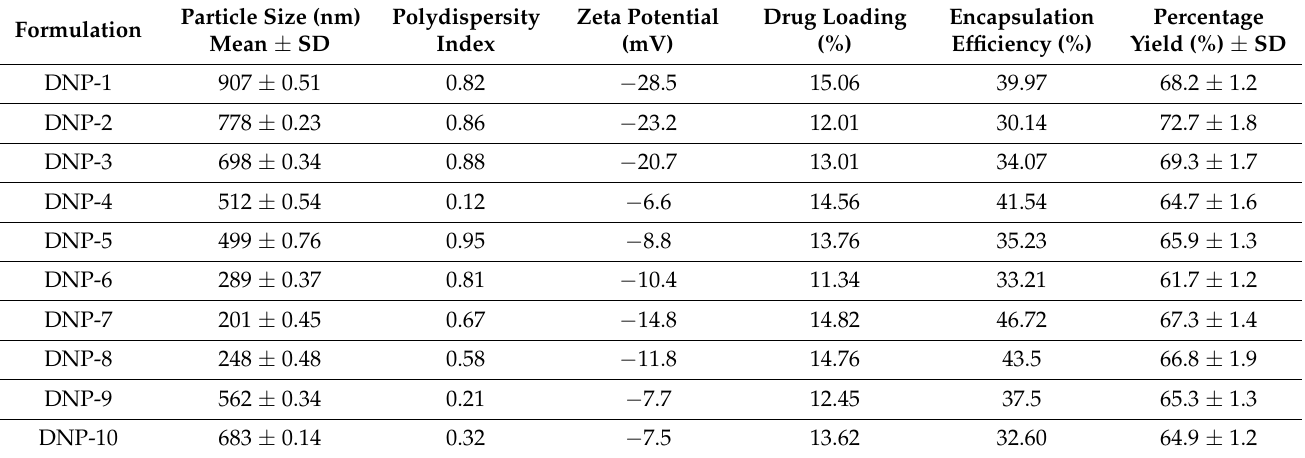
Table 3. The optimized formulation’s (DNP-7) spectra displayed all the characteristic